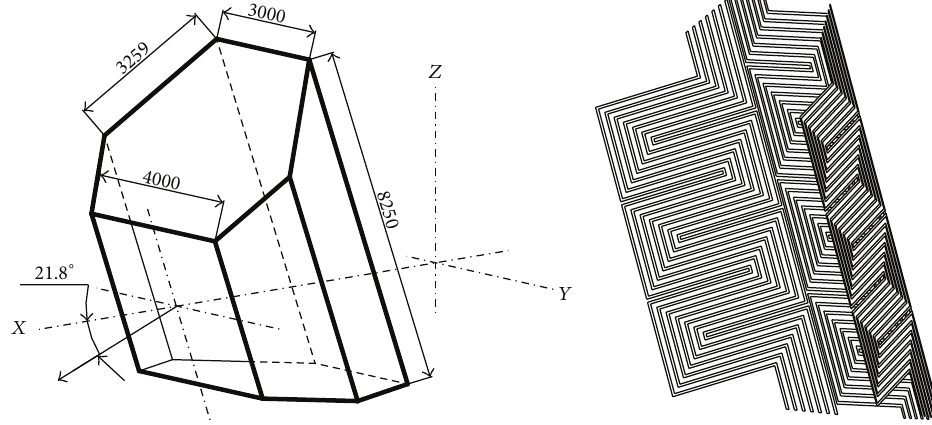
Figure 1: Cavity geometry and absorber tubes